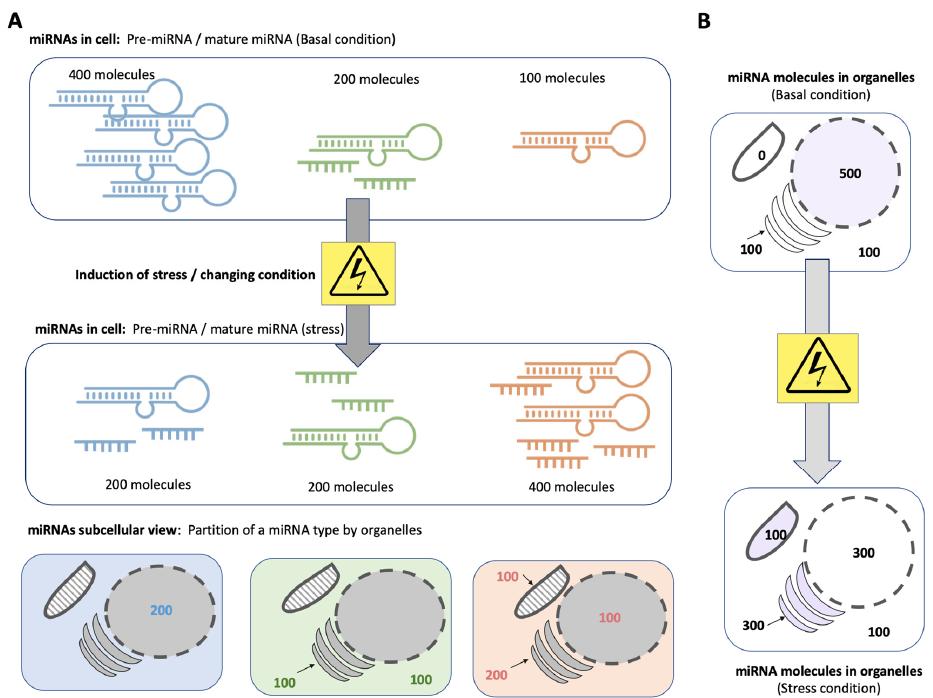
Figure 3. Illustration of a cell exposed to a stress condition: ( A ) The view of three types of miRNAs (denoted by their color), and the changes in the miRNA quantities and/or processing in response to stress. The subcellular localization of the miRNA molecules is illustrated. ( B ) A cellular view on miRNA localization. Organelles that are signified by maximal changes in miRNA number before and after external stress are colored.